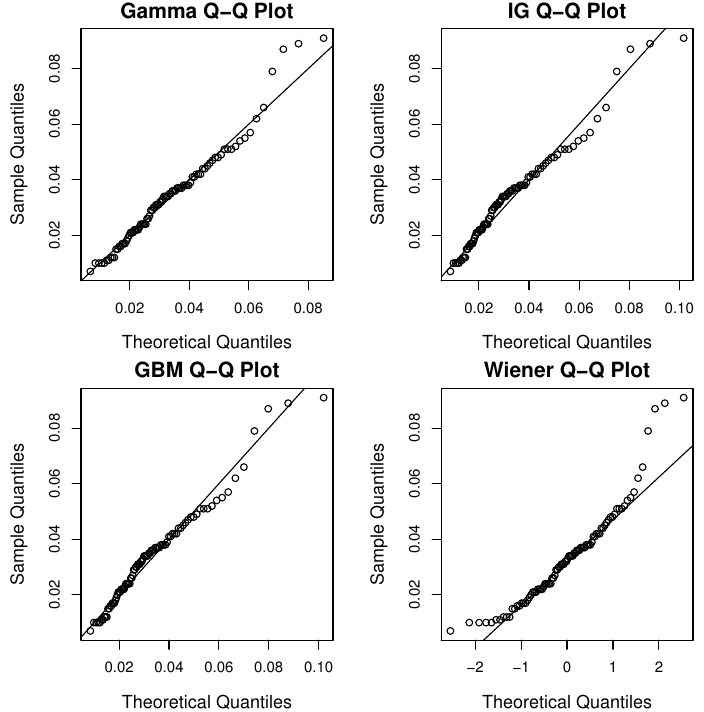
Figure 7. Q-Q plots for true degradation under different stochastic